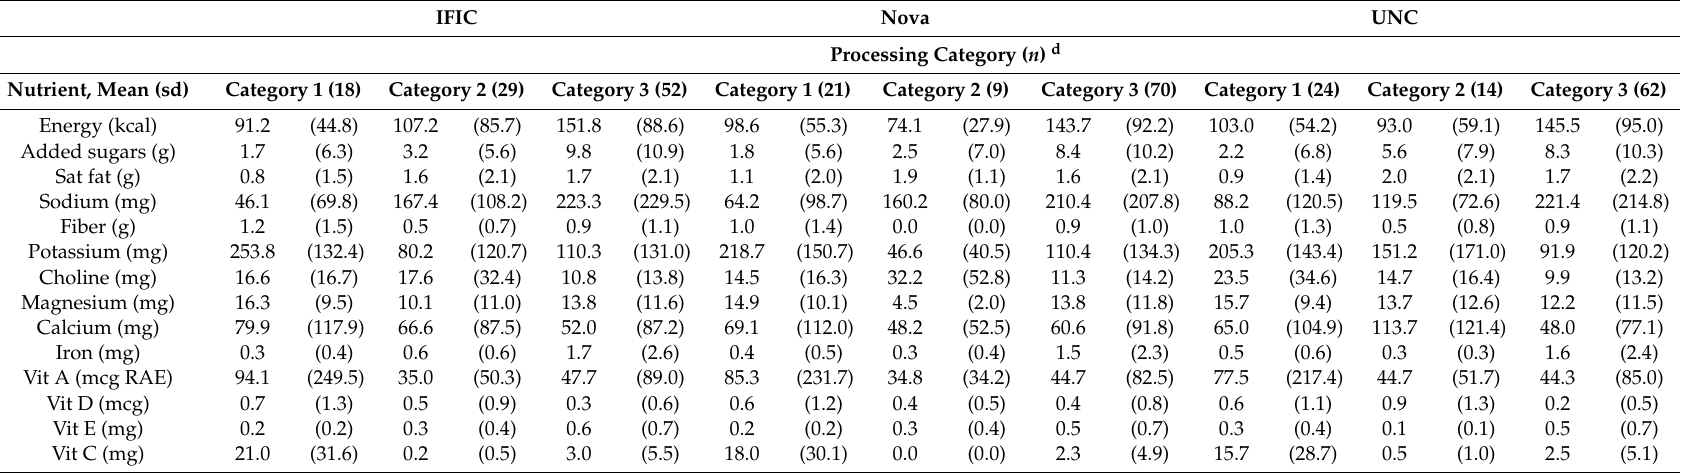
Table 2. Mean nutrient concentration per 100 g of the top 100 foods consumed by children 6–12 years old by processing category for the IFIC a [15], Nova [14], and UNC b [13] systems, NHANES c